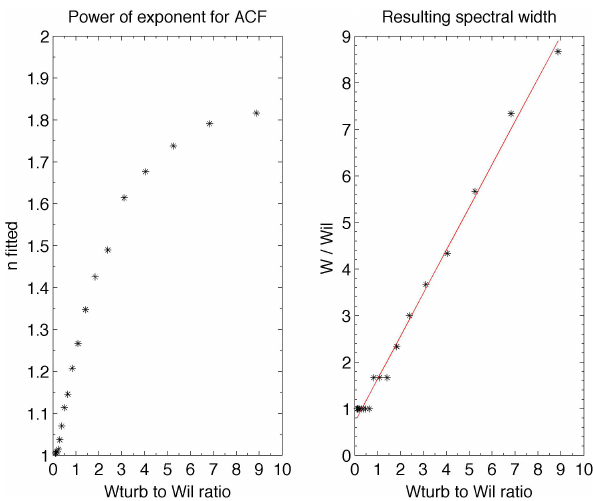
Fig. 11. Left panel: the power of the exponential fit for the ACF resulting from initial Lorentzian spectrum with width W il plus con- tribution from the random Doppler velocities representing turbulent velocities with distribution width W turb as a function of the W turb to W il ratio. Right panel: the ratio of the resulting W to initial W il spectral width as a function of the W turb to W il ratio. The red line is a linear